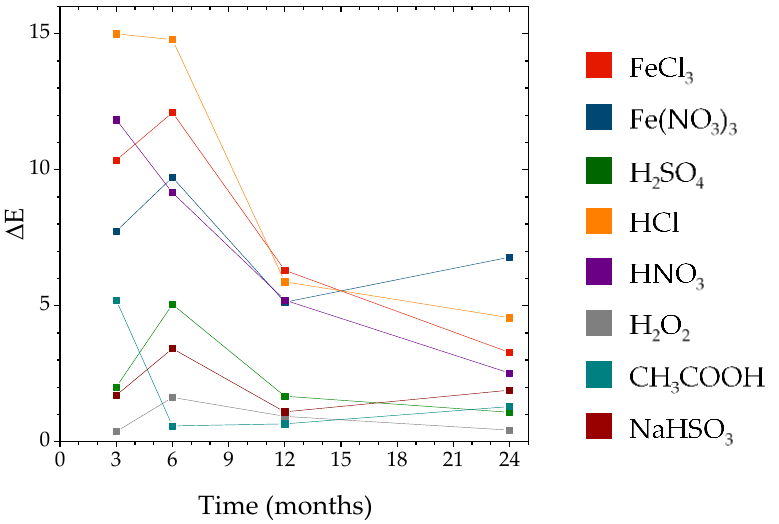
Figure 8. ∆ E values comparing natural patina with accelerated patinas over time for 24 months period of atmospheric exposure.